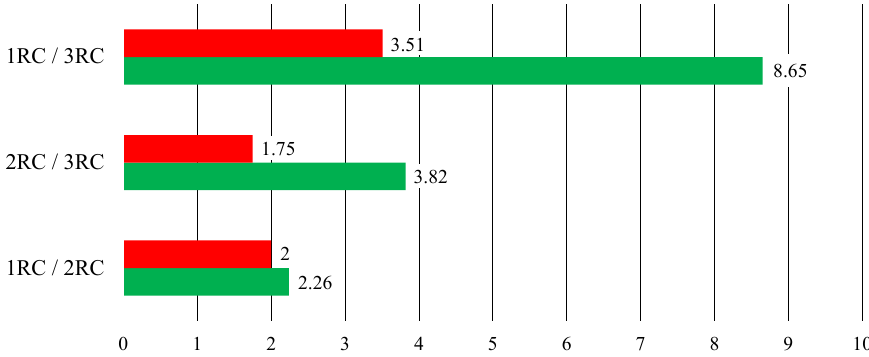
Figure 9. Comparisons of the different RC -pair models relative to the computational effort (red) and accuracy (green).